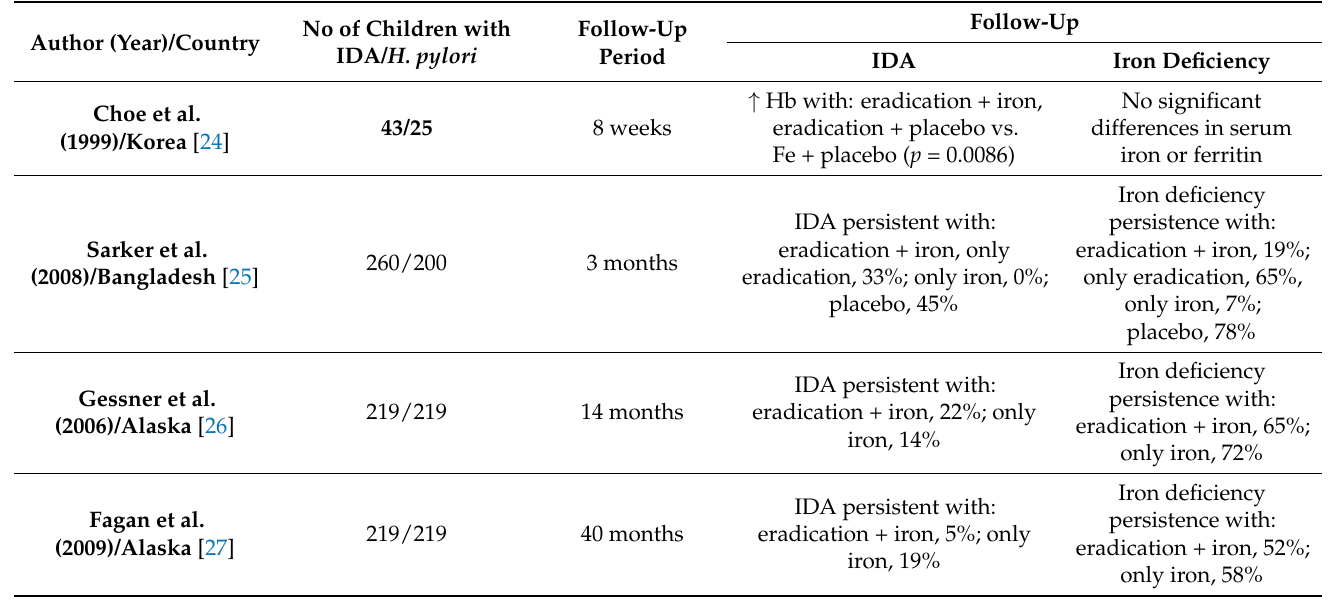
Table 4. Randomized clinical trials of H. pylori eradication for iron-deficiency anemia and iron deficiency in